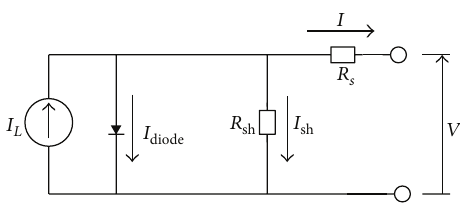
Figure 1: Five lumped parameters cell